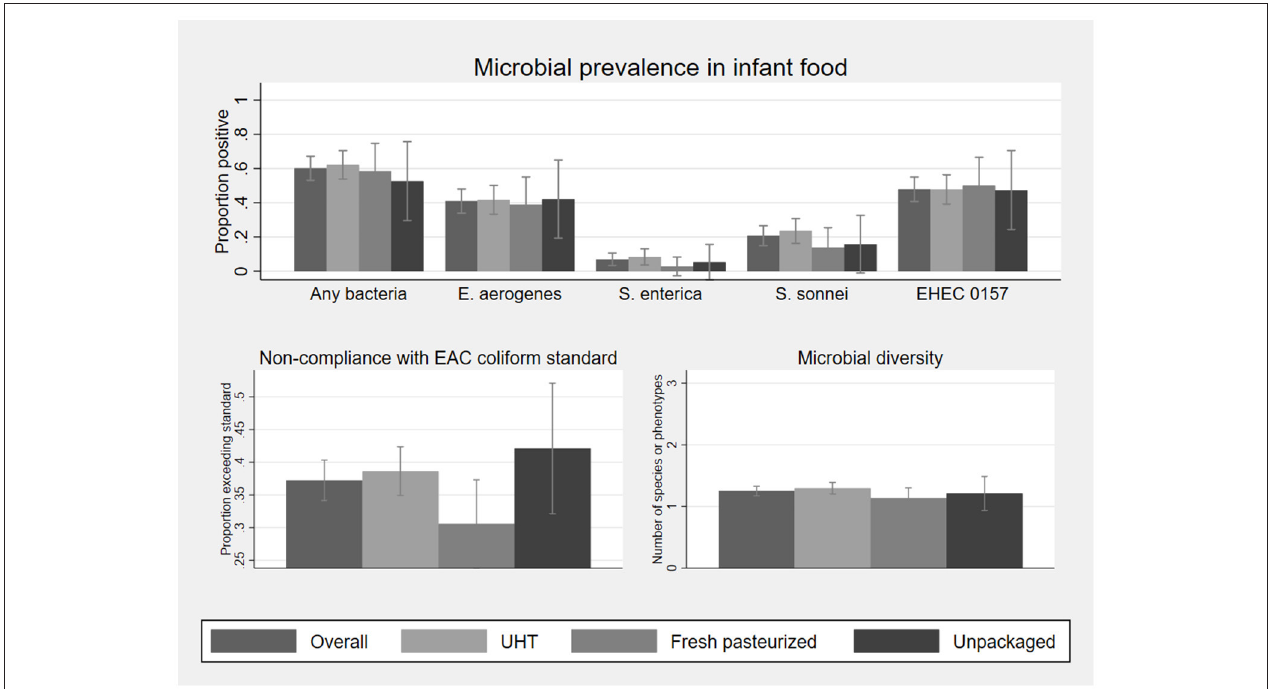
FIGURE 3 | Microbial prevalence, compliance with EAC coliform standard for pasteurized milk, and microbial diversity, of 187 infant food samples matched to fluid milk samples collected at point of purchase, by milk type. Sample sizes by milk type are 132 UHT, 36 fresh pasteurized, and 19 unpackaged. Statistics on which this figure is based, as well as mean bacterial concentration among positive samples, are shown in Supplementary Table S5 . EHEC 0157 was classified based on phenotype and not validated as a human pathogen. Error bars represent 95% confidence intervals.